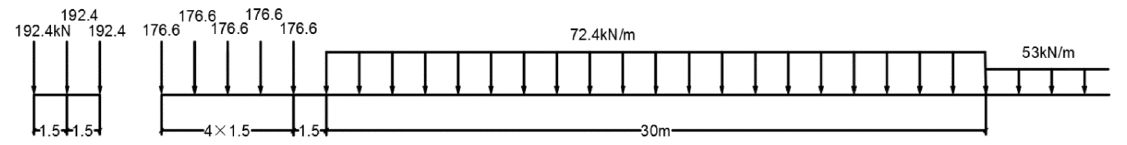
Fig. 20 the live load of the Chinese Standard-18